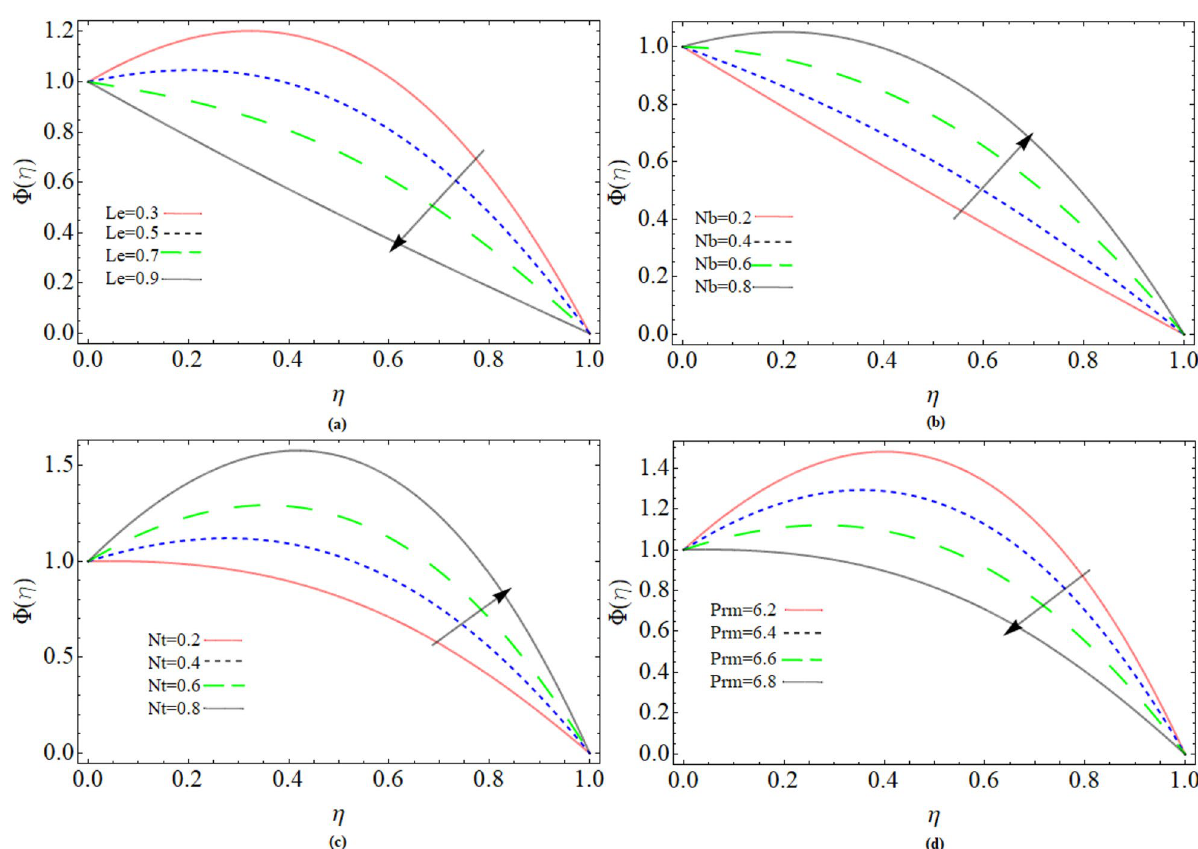
Figure 4. Parameter Le , Nt , Nb and Prm effect on concentration profile �(η)